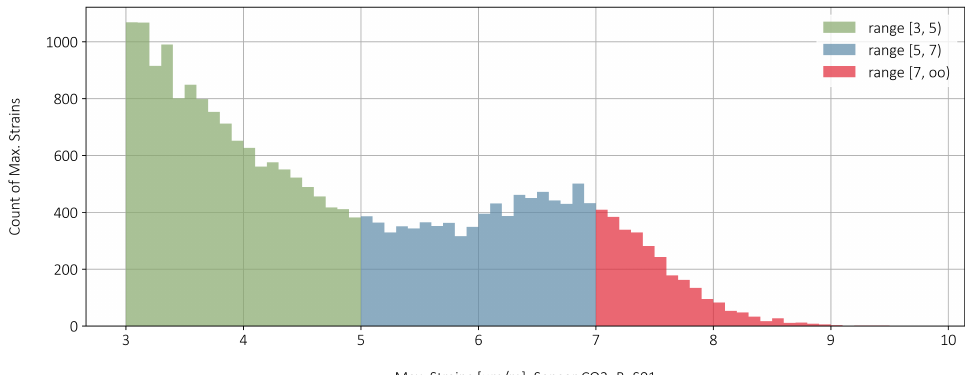
Figure 11. Histogram of the strain peaks for May